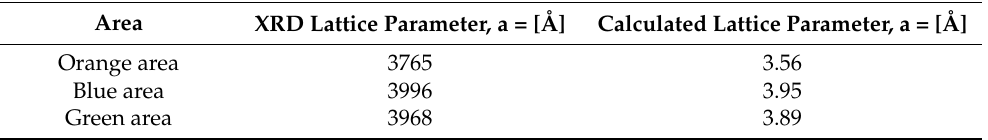
Table 4. Field lattice parameters obtained by XRD analysis and calculated analysis (Vegard’s law) [13]. Area XRD Lattice Parameter, a = [Å] Calculated Lattice Parameter, a = [Å] Orange area 3765 Blue